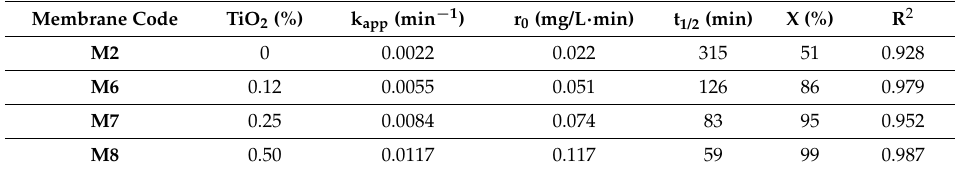
Table 5. Values of apparent constants (k app ), time of half- reaction (t 1/2 ) and initial velocities (r 0 ) for different amounts of TiO 2 .